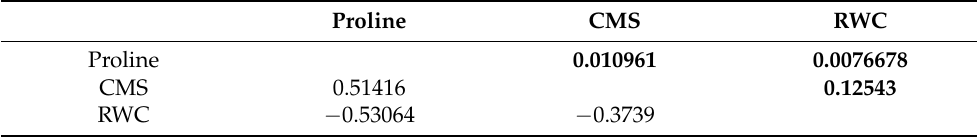
Table 1. Pearson’s correlation coefficients between proline, CMS and RWC measured in the ten T. durum cvs. Bolded values correspond to p